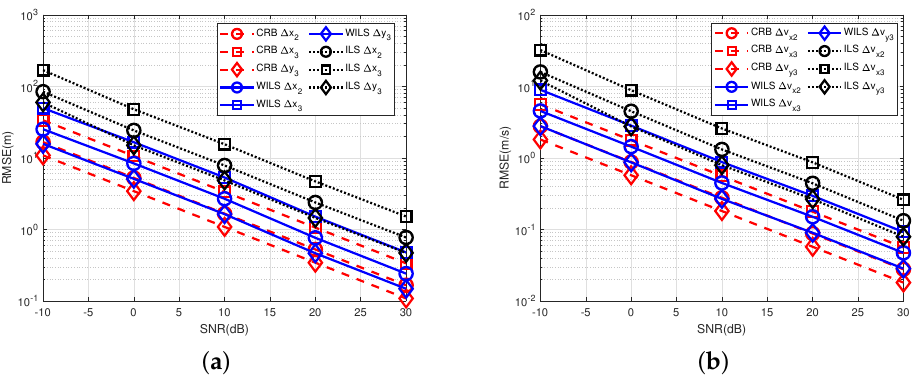
Figure 10. Estimation results for different methods in the presence of different SNRs in different propagation paths ( a ) RMSE for the radar position deviations estimation, ( b ) RMSE for the radar velocity deviations